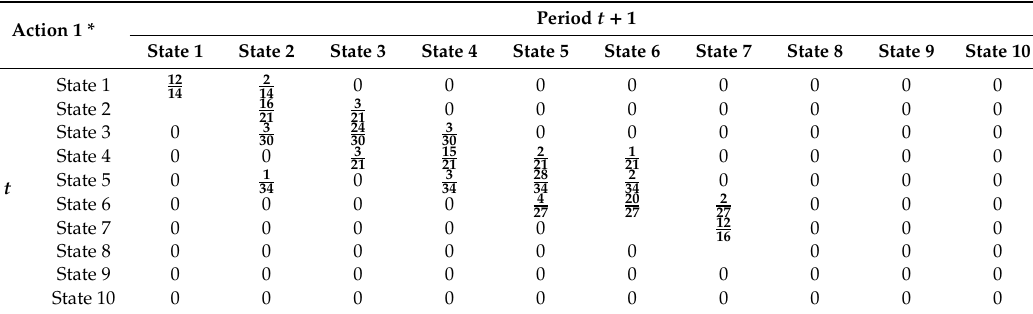
Table A2. Transitions probability matrix of action